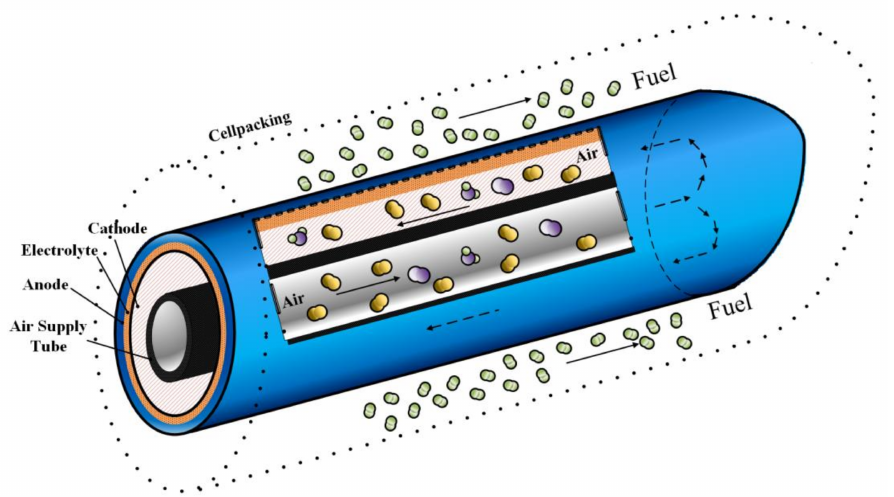
Figure 2. The cutaway diagram of a tubular solid oxide fuel